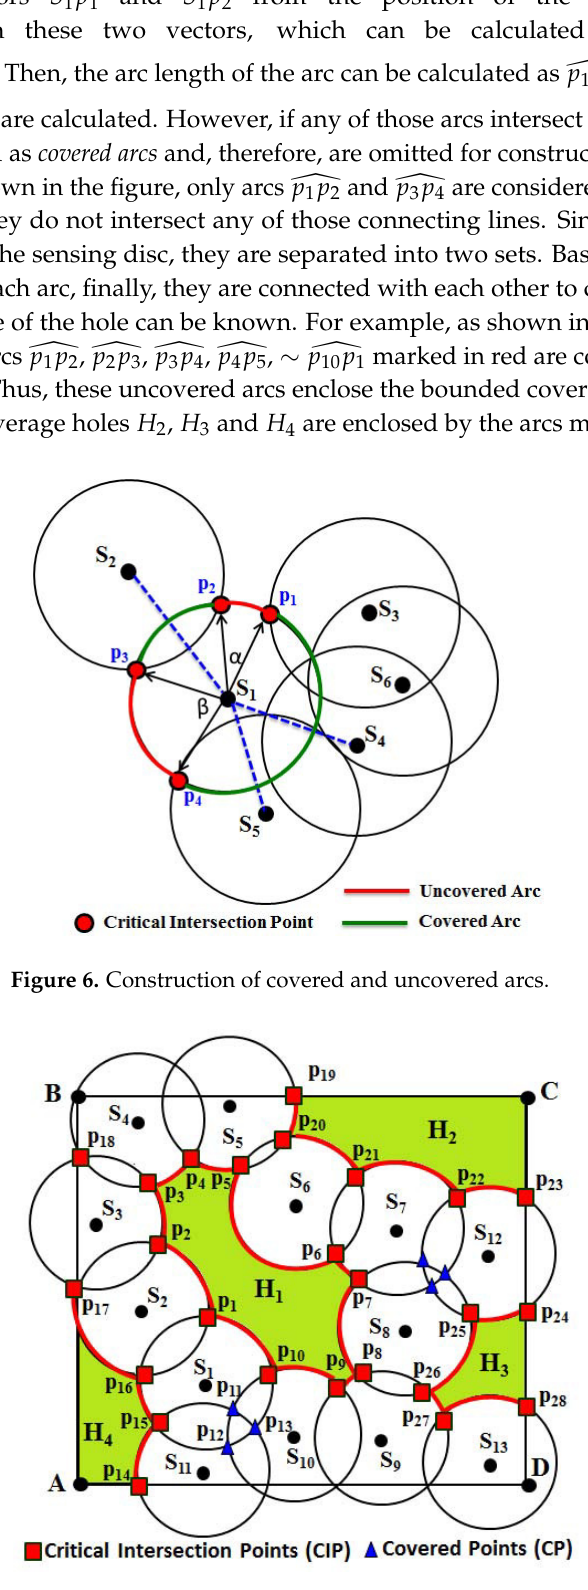
Figure 7. Formation of coverage holes using the uncovered